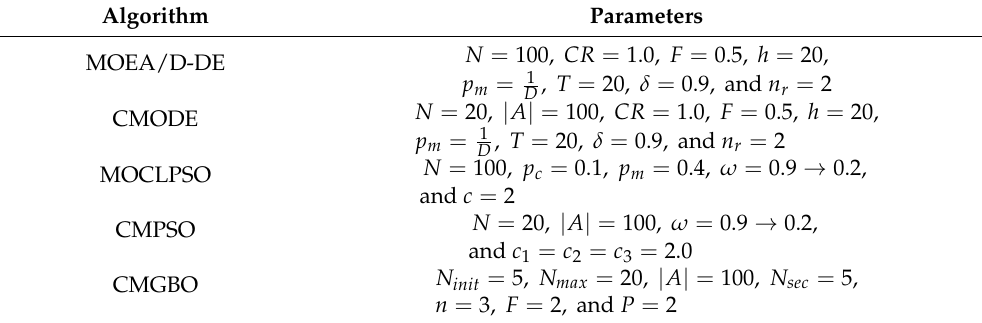
Table 1. Preferences settings.